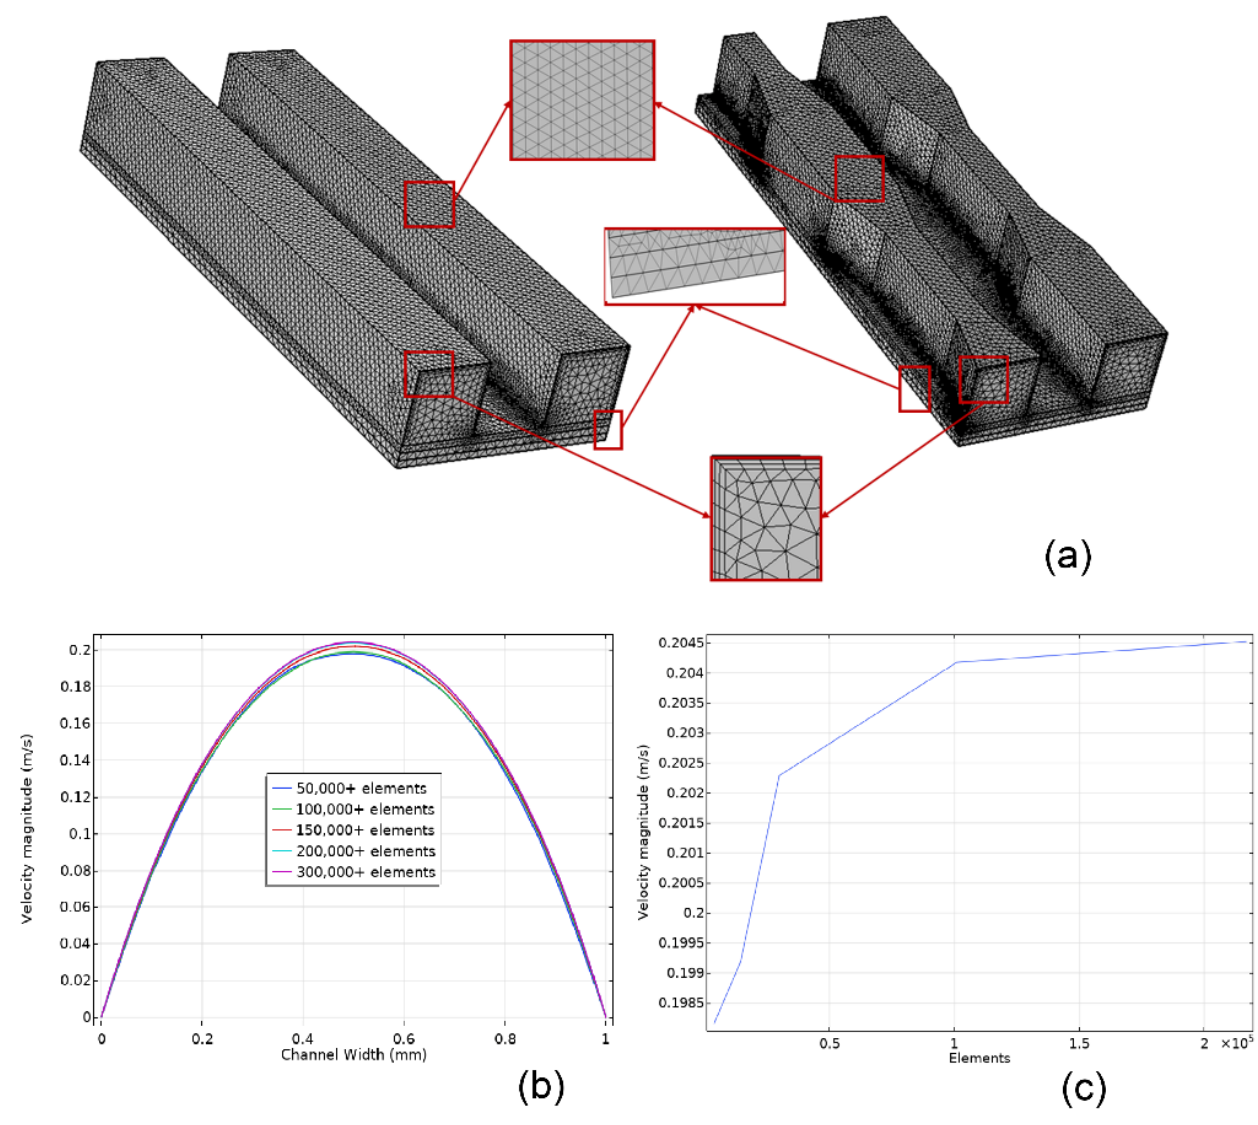
Figure 3. Mesh independence validation: ( a ) FEM discretization mesh of the conventional channel and the novel channel; ( b ) channel gas velocity magnitude lines with a variety of elements; ( c ) channel gas velocity probe curve with different elements.